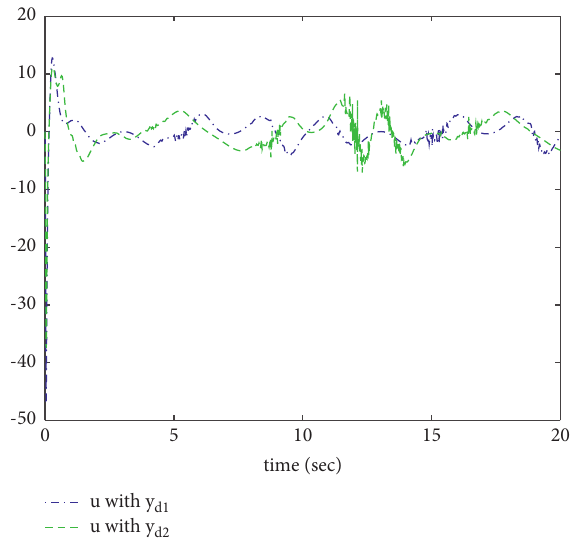
Figure 8: The control inputs u with x